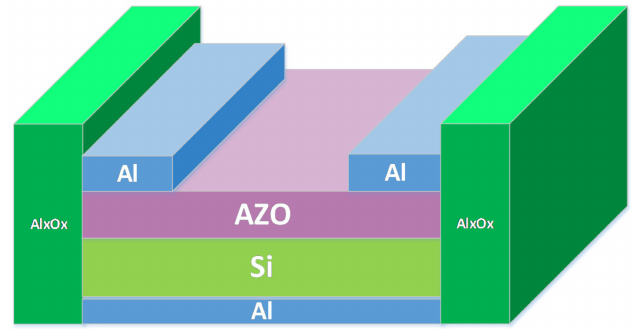
Figure 1. The structure of the AZO/Si diode with Al x O x guard